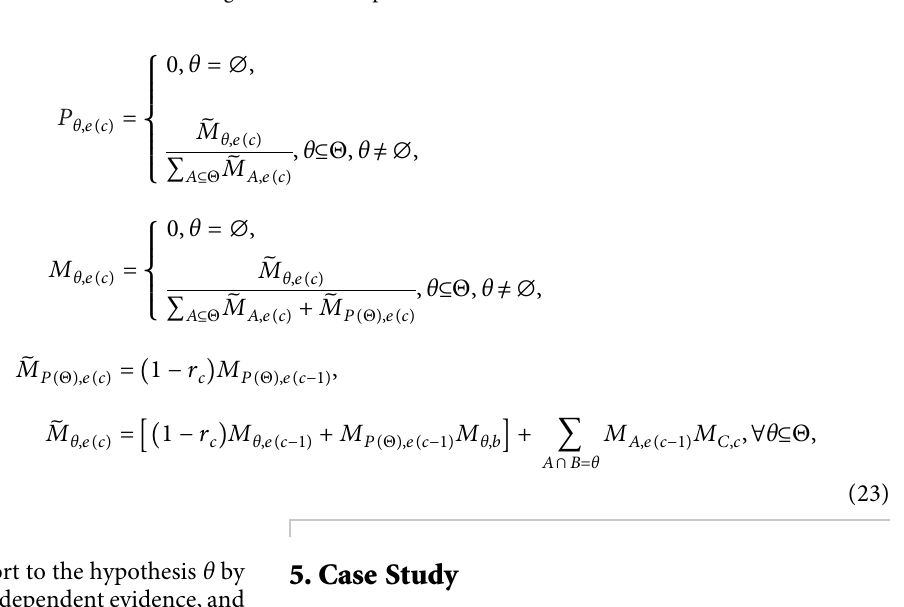
Figure 3: Weight of evidence